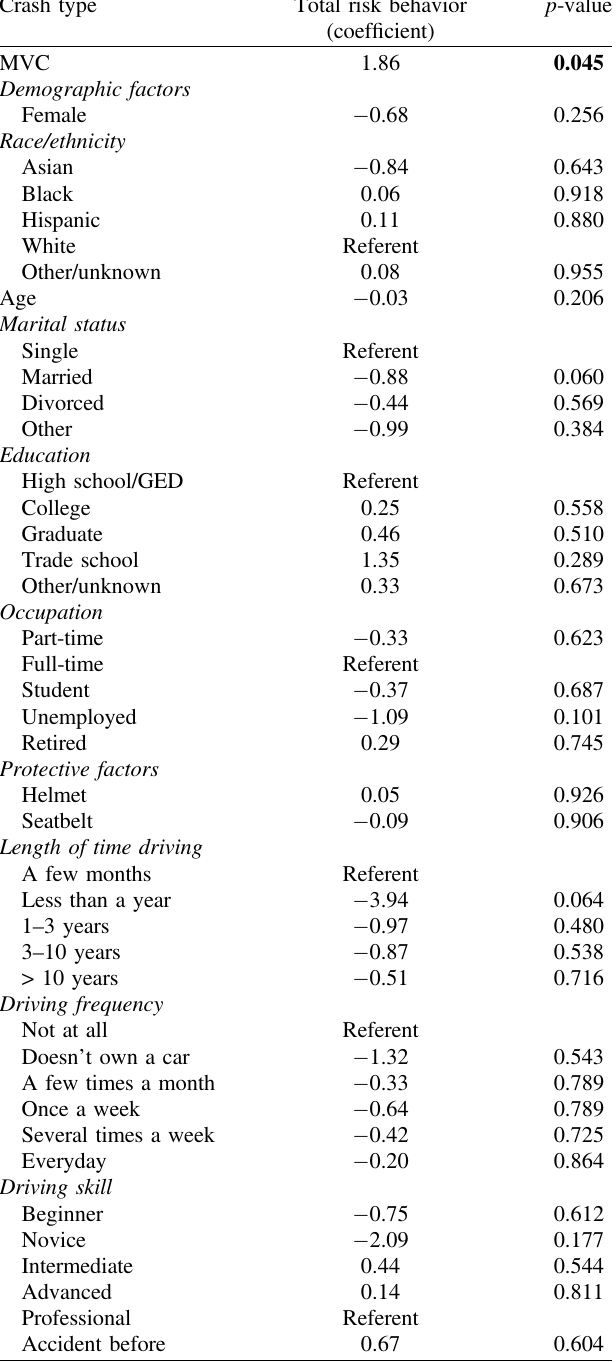
Table 5. MVC associated with increased risk behavior after controlling for demographic and protective